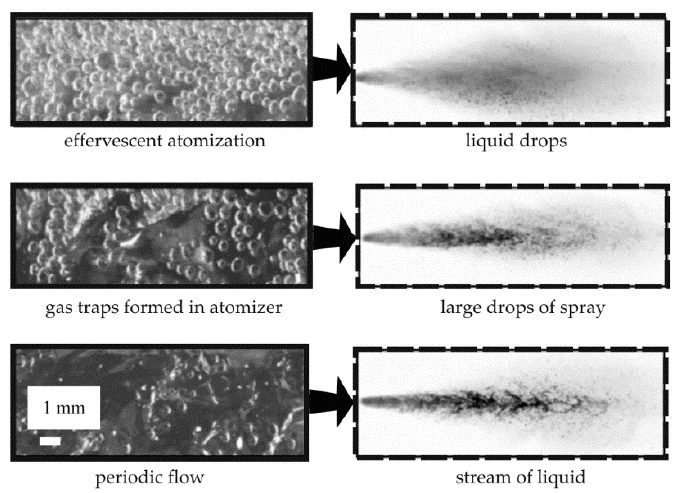
9 of 30 Figure 5. Schematic diagram of the two-phase atomization process in an effervescent atomizer [7,8]. Different flow structures are distinguished in the outlet opening: effervescent, ring- dispersion, annular, cork, and foam, as shown in Figure 6 [75–82]. The effervescent struc- ture is characterized by a small number of tiny bubbles that are evenly distributed throughout the volume. However, in the cork structure there is an object called a cork. In the cork structure, the relative interphase surface decreases with respect to the bubble structure. On the other hand, in the foam structure, the occurrence of a large irregular object can be observed. The number of objects in the tested volume decreases, while the